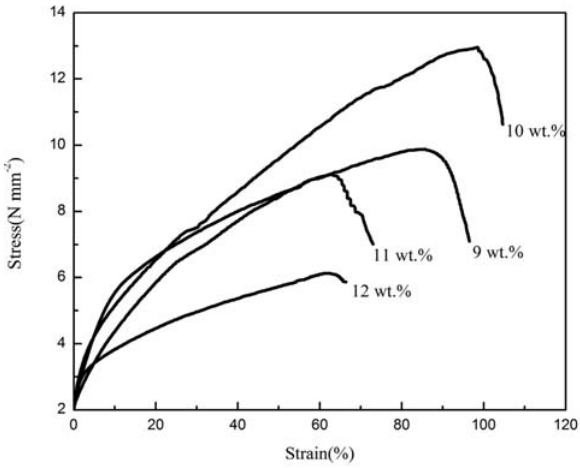
Fig. 7. Stress strain curves of different concentration of electrospun PVDF/TPU /PS membranes Fig. 8. Linear sweep voltammograms of the gel polymer electroly- Table 3. Mechanical properties of different concentration of elec- trospun PVDF/TPU /PS Samples Stress (Mpa) Strain (%) TPU/PVDF/PS (9 wt.%) 9.9 ± 0.2 85.4 ± 0.2 TPU/PVDF/PS (10 wt.%) 11.9 ± 0.2 94.2 ± 0.2 TPU/PVDF/PS (11 wt.%) 9.14 ± 0.2 63.2 ± 0.2 TPU/PVDF/PS (12 wt.%) 6.16 ± 0.2 62.8 ±